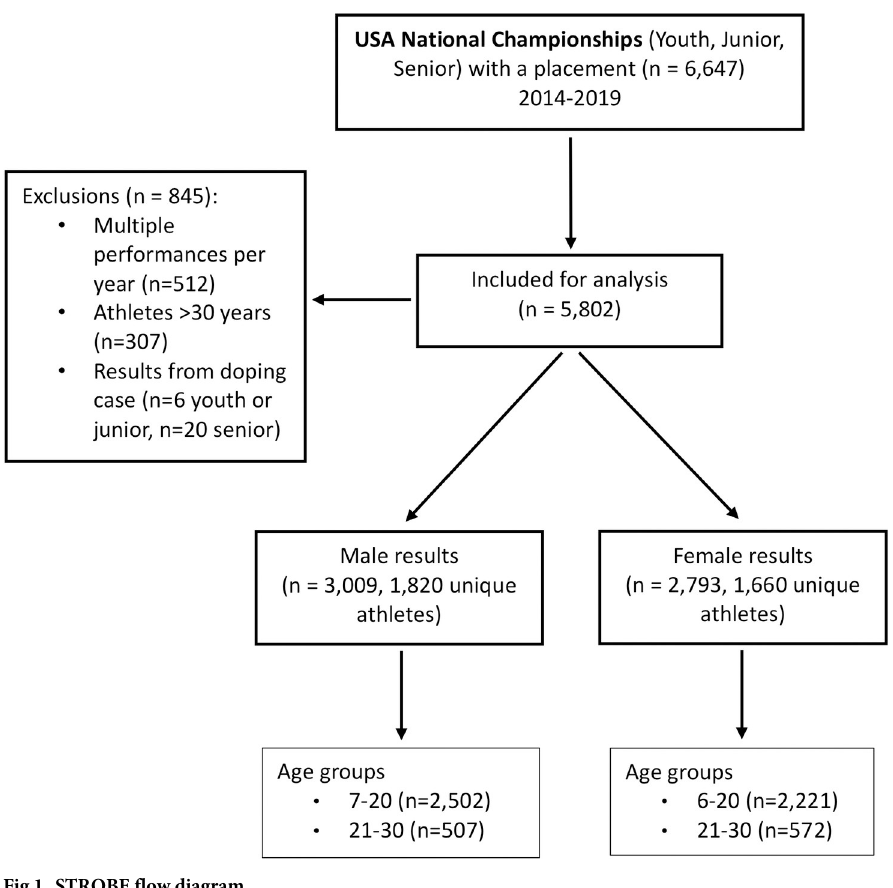
Fig 1. STROBE flow